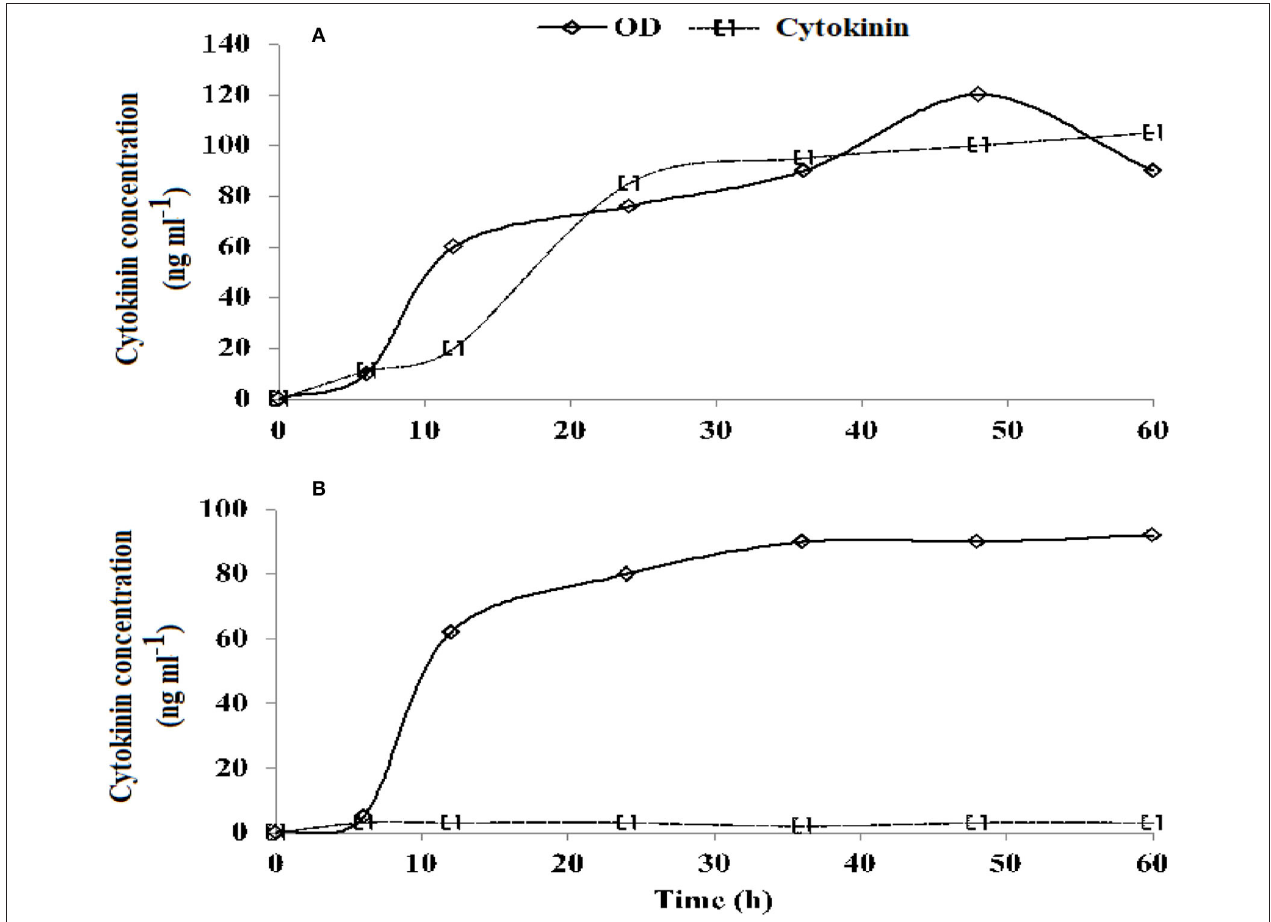
FIGURE 1 | Growth curve (OD, optical density) and cytokinin (Ck accumulation) of a cultured medium of Azospirillum brasilense RA − 17 (A) and RA − 18 (B) .